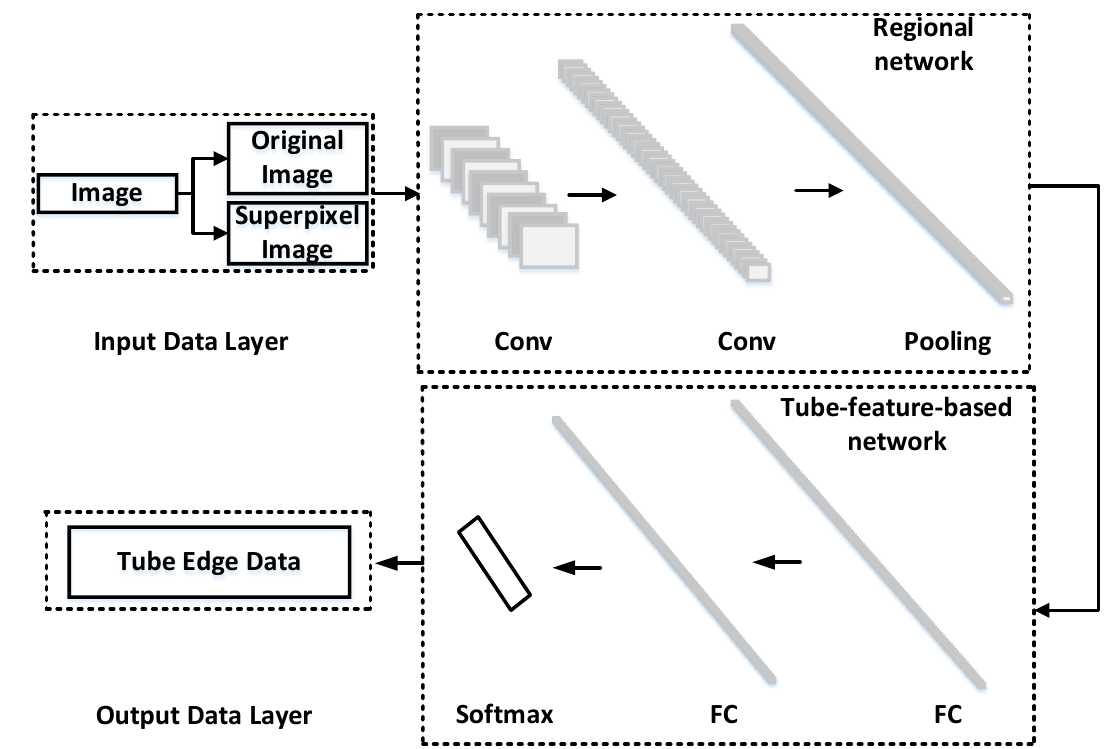
Figure 5. The convolutional neural network of edge detection.